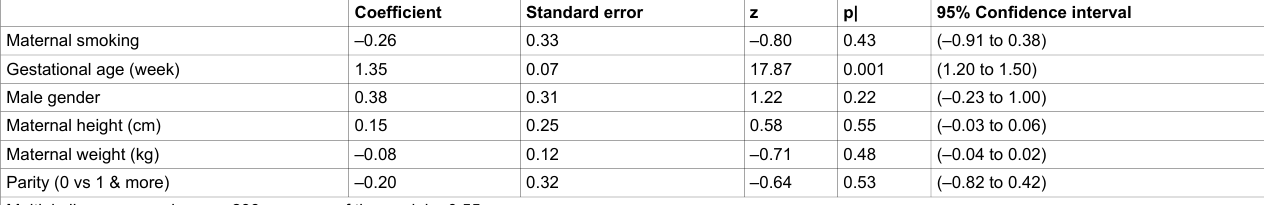
Table IVa: The impact of maternal smoking on the length of very preterm